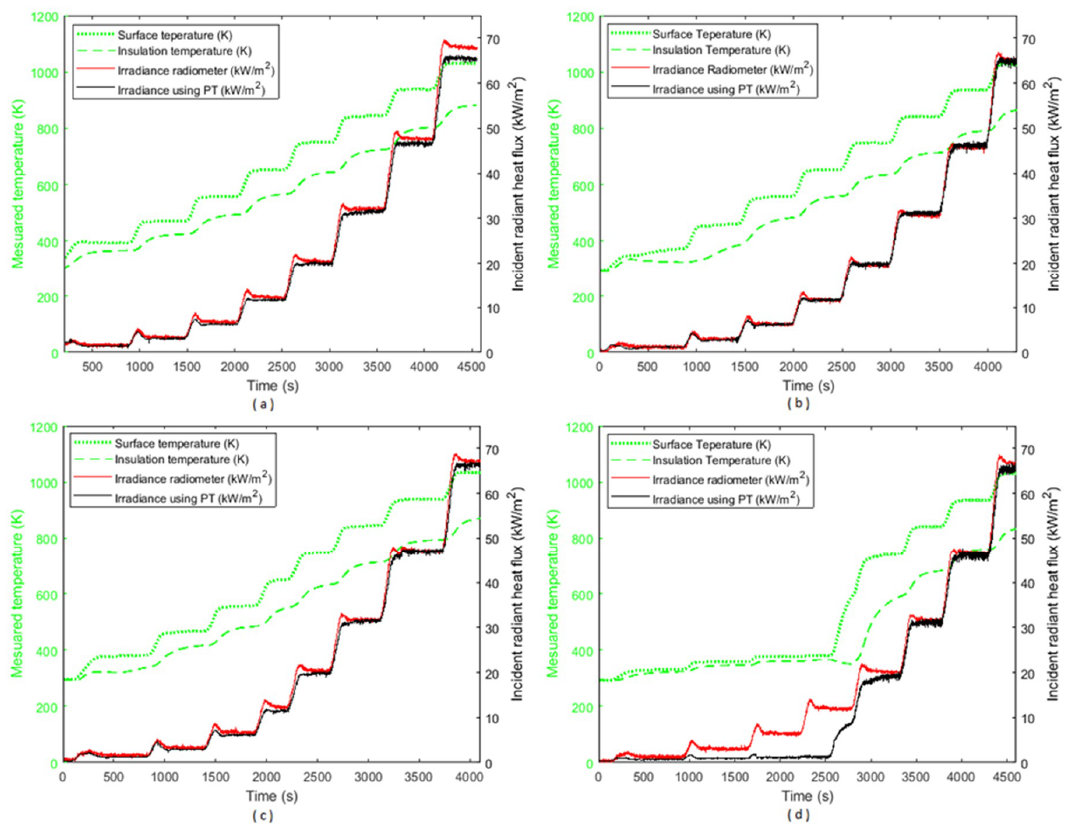
Figure 5. ( a ) Experiment results for 0%WME PT; ( b ) Experiment results for 45%WME PT; ( c ) Experiment results for 65%WME PT; ( d ) Experiment results for 98%WME PT.